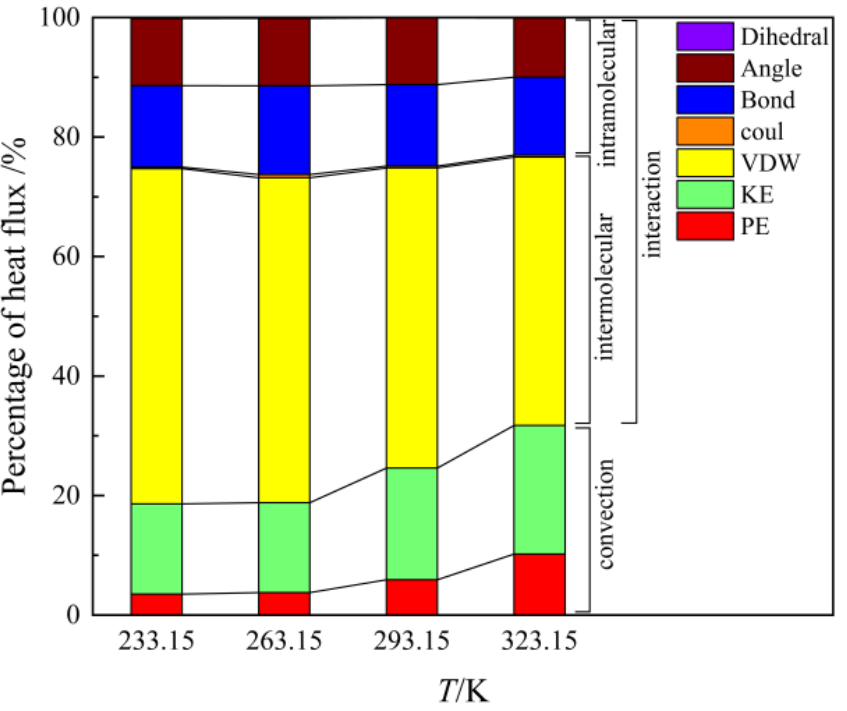
Figure 4. Contribution of each part to the total heat flux in the conduction process of C 2 H 5 OH at different temperatures.